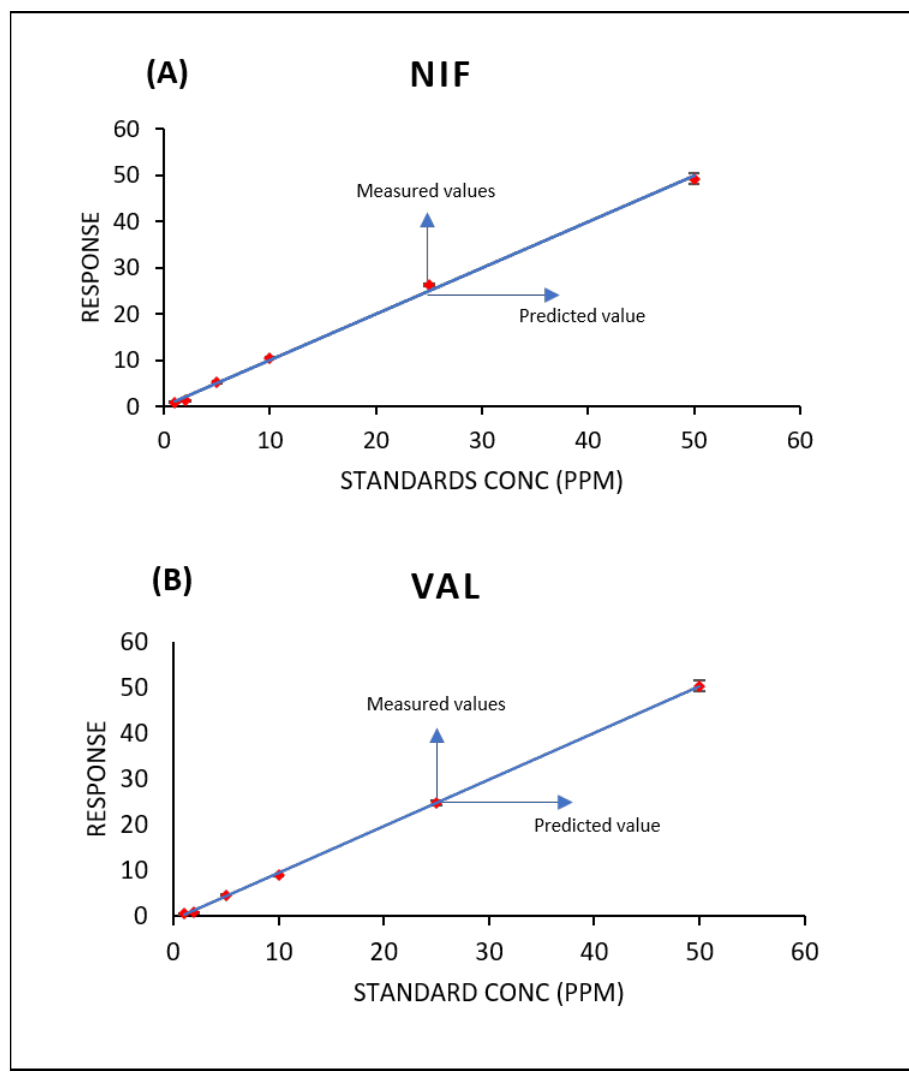
Figure 3. Linear regression model of (A) NIF and (B) VAL in which the differences between observed and predicted values have been shown. Table 5. The percent deviation of nine replications of each